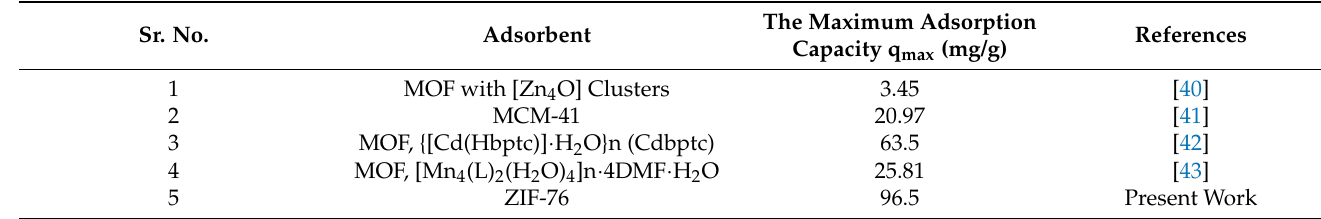
Table 2. Comparison of the MG removal rates of different MOFs’ adsorption capabilities. Sr.